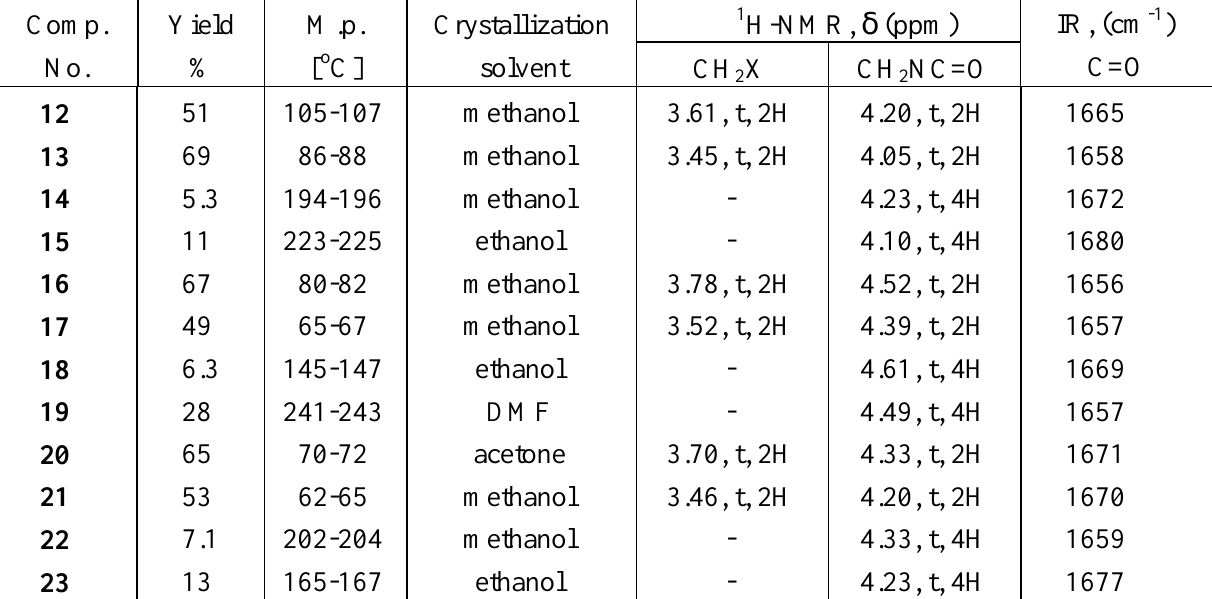
Table 1. Reaction yields, physical properties and spectral data of halogen- ( 12 , 13 , 16 , 17 , 20 and 21 ) and disubstituted derivatives ( 14 , 15 , 18 , 19 , 22 and 23 ) of quinazolidin-4( 3H )-one ( 7 ), 2-phenyl-2,3-dihydrophthalazine-1,4-dione ( 8 )